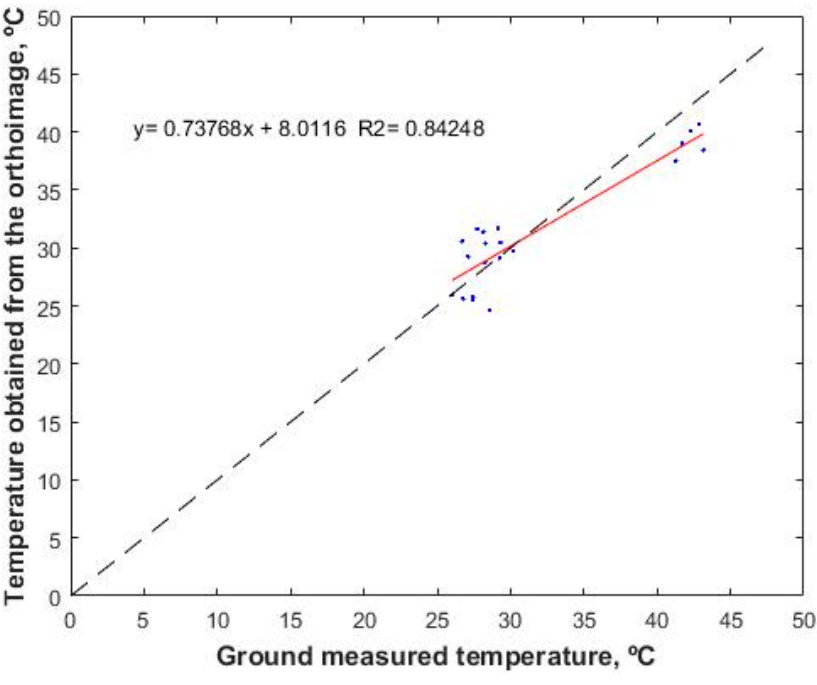
Figure 12. Comparison of the data obtained in the field with the data obtained from the generated geomatic product.